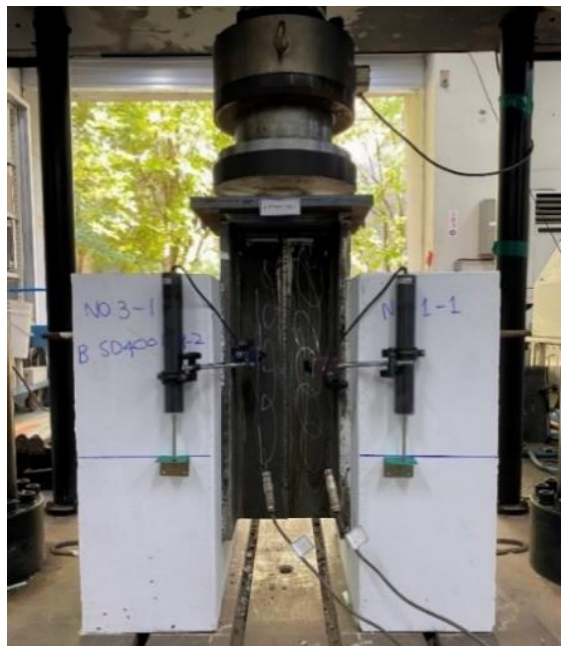
Figure 4. Test set-up of the push-out test.